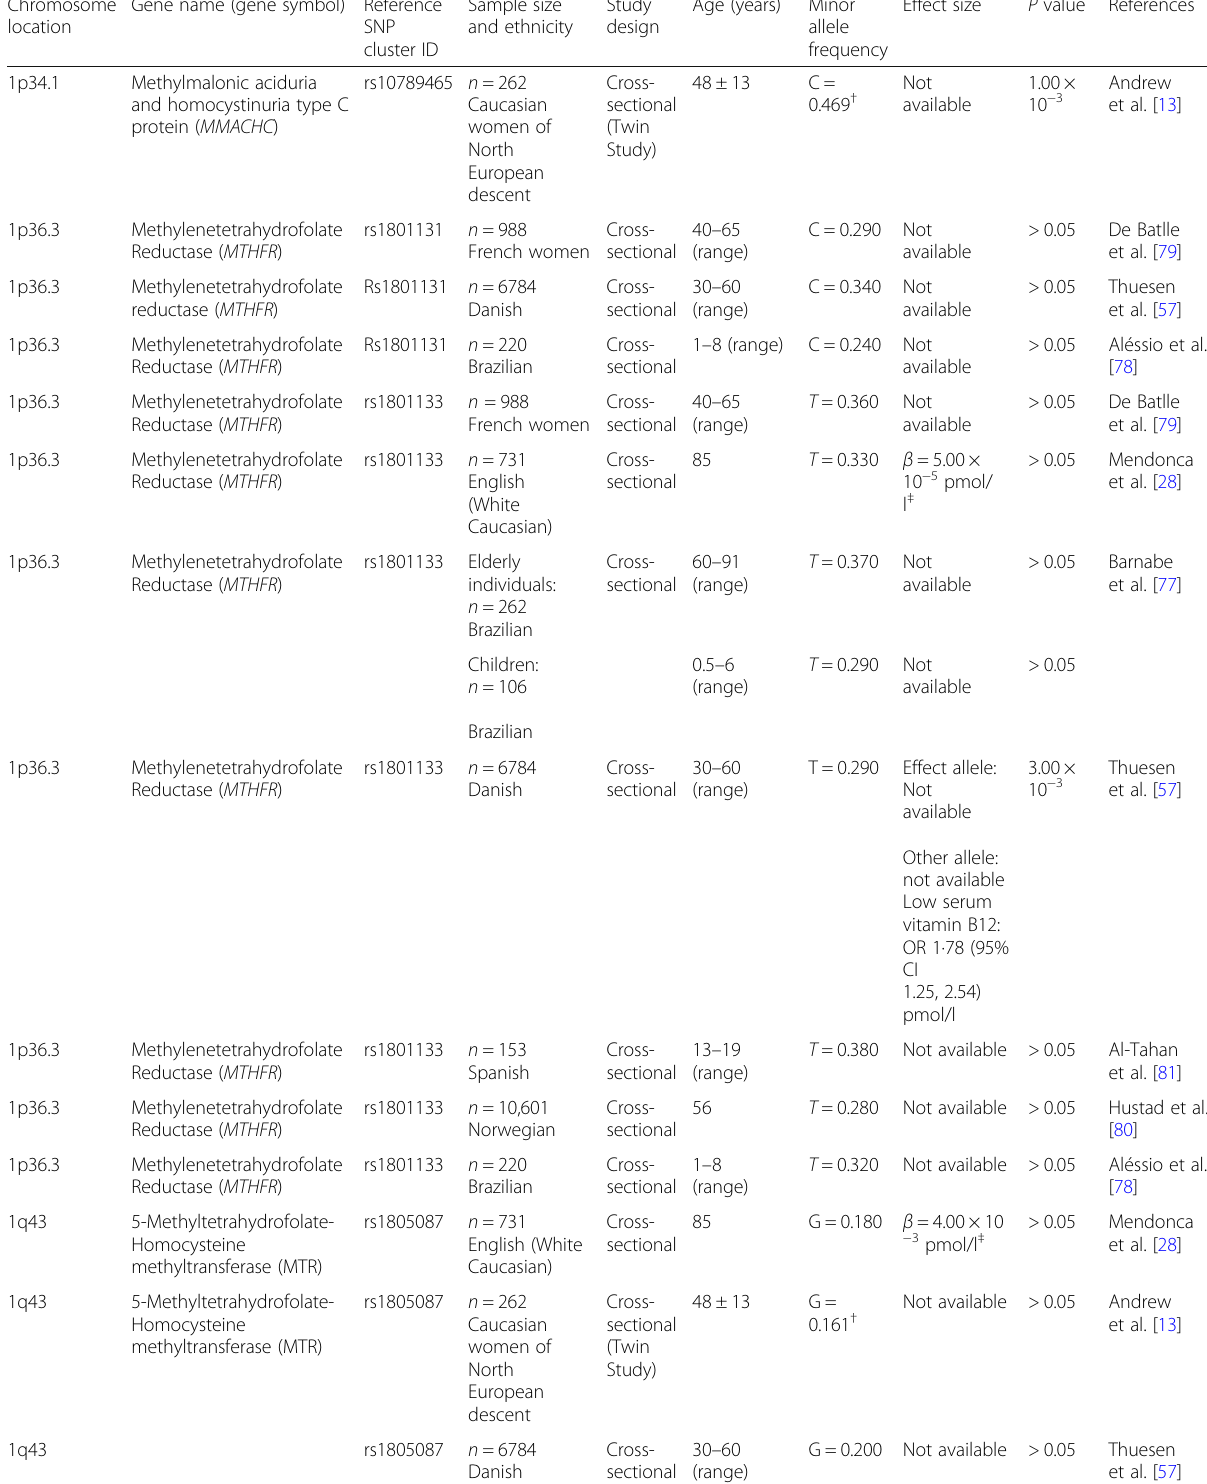
Table 2 Candidate gene association studies examining the association of SNPs with vitamin B12 concentrations. Candidate gene association studies testing the association between SNPs and vitamin B12 concentrations. The chromosome location, gene name, reference SNP cluster ID, sample size and ethnicity, study design, mean age, observed frequency of the minor allele in the population, effect size and P value are shown in the table. The order of SNPs reflects the order of the chromosome